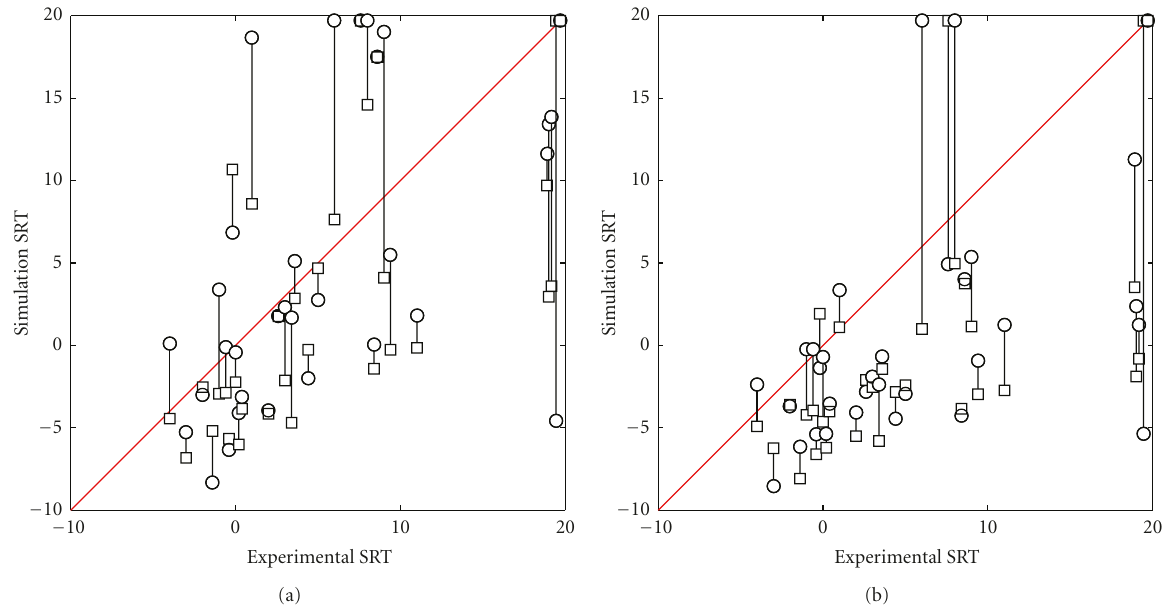
Figure 7: Speech recognition threshold for 32 CI users, as measured experimentally and as predicted by models A (a) and B (b). Each line connects the SRT predicted from the test (circles) and retest (squares) data. The SRT is expressed in dB and a lower value means better speech